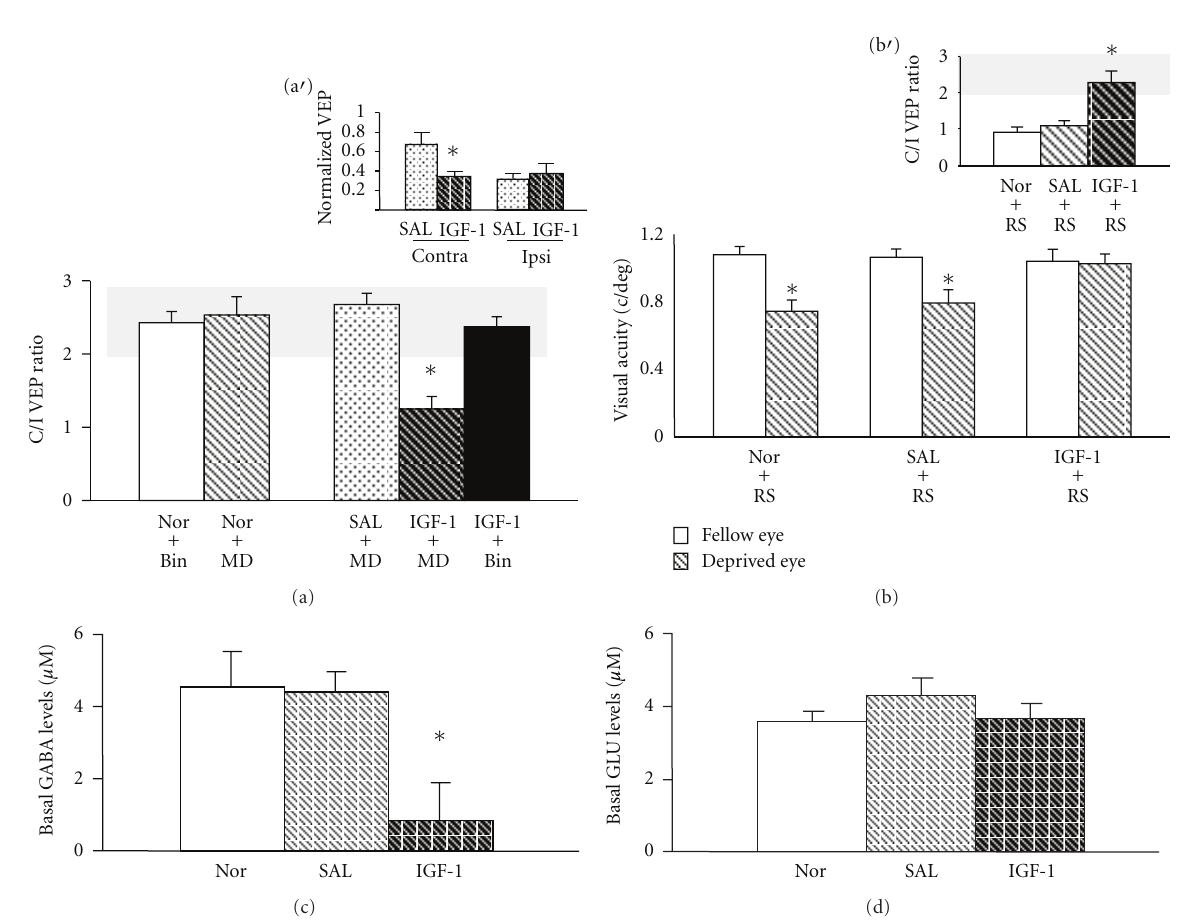
Figure 1: IGF-1 treatment reactivates plasticity in the adult visual cortex and decreases intracortical GABA levels. (a) An OD shift in favor of the open eye was evident in IGF-1-infused rats (IGF-1+MD; n = 5, C/I VEP ratio = 1.2 ± 0.17) with respect to adult animals with binocular vision (Nor+Bin; n = 5, C/I VEP ratio = 2.42 ± 0.16, one-way ANOVA P = 0 . 0002, post hoc Holm Sidak method, P < 0 . 05). No modification of the C/I VEP ratio was detected in either saline-treated animals (SAL+MD; n = 5, C/I VEP ratio = 2.67 ± 0.15, One-way ANOVA, post hoc Holm Sidak method) or normal adult rats (Nor+MD; n = 7, C/I VEP ratio = 2.53 ± 0.25, One-way ANOVA, post hoc Holm Sidak method). IGF-1 treated rats with binocular vision (IGF-1+Bin; n = 3) exhibited a C/I VEP ratio (2.37 ± 0.12) completely comparable to that of untreated Nor+Bin animals (One-way ANOVA, post hoc Holm Sidak method). Insert: the change of OD in IGF-1-treated rats was due to a decrease of the deprived eye (contra) strength. The amplitude of VEPs recorded in response to the stimulation of the occluded eye in IGF-1+MD rats (0.35 ± 0.05) was significantly lower with respect to that obtained in saline-treated animals following MD (0.68 ± 0.12; t -test; P = 0 . 047). No di ff erence was detected in VEP amplitudes recorded after the stimulation of the open (Ipsi) eye (IGF-1+MD: 0.38 ± 0.11; SAL+MD: 0.32 ± 0.05; t -test; P = 0 . 627). VEP amplitudes at the recording site in the VC contralateral to the occlusion were normalized to the sum of the response to stimulation of the contralateral and ipsilateral eye, as described previously [10–12]. (b) Full rescue of VA was evident in reverse-sutured IGF-1 treated rats (IGF-1+RS, n = 5): VA of the long-term deprived eye (0.93 ± 0.06 cycles per degree, c/deg) was not di ff erent from that of the fellow eye (0.94 ± 0.04 c/deg; paired t -test, P = 0 . 837). No sign of recovery was detected either in reverse-sutured animals infused with saline (SAL+RS, n = 5; VA for the long-term deprived eye = 0 . 72 ± 0 . 03 c/deg; VA for the open eye 0.96 ± 0.01 c/deg; paired t -test, P < 0 . 001) or in reverse-sutured normal rats (Nor+RS, n = 5; VA for the long-term deprived eye = 0.67 ± 0.01 c/deg; VA for the open eye 1.03 ± 0.03 c/deg; paired t -test; P < 0.001) Insert, while in Nor-RS rats (C/I VEP ratio = 1.02 ± 0.08) there was no recovery of binocularity (One-way ANOVA, post hoc Holm Sidak method); in IGF1+RS the C/I VEP ratio is in the range of normal adult values (C/I VEP ratio 2.12 ± 0.13, One-way ANOVA, F (3-16) = 40.24, P < 0 . 0001, post hoc Holm Sidak method). No recovery of OD was detected in SAL+RS animals ( n = 5; C/I VEP ratio = 0.86 ± 0.11; One-way ANOVA, post hoc Holm Sidak method). (c) Extracellular GABA levels were significantly lower in the VC of IGF-1-treated rats (IGF-1; n = 6; 0.87 ± 0.17 μ M) with respect to saline-treated (SAL; n = 5; 4.46 ± 0.17 μ M) and untreated animals (Nor; n = 8,4 . 62 ± 0 . 97 μ M; One-way ANOVA, F (2–16) = 7.445, P = 0 . 0052, post hoc Tukey test, P < 0 . 05). (d) No change in glutamate (GLU) levels between IGF-1-treated (3.88 ± 0.4 μ M) and control groups (SAL: 4.48 ± 0.6 μ M; Nor: 3.74 ± 0.3 μ M) was detected (One-way ANOVA, F (2–15) = 0.744, P = 0 . 491). The grey box denotes the C/I VEP ratio range in adult normal animals. ∗ Statistical significance. Error bars indicate